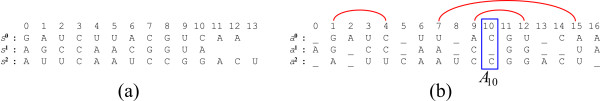
An SAF instance, and a corresponding alignment with folding. (a) An SAF instance S, composed of three RNA strings s0, s1, and s2. (b) A possible alignment with folding (A, F) of S, where |A| = 17, and F = {1 • 4, 7 • 15, 9 • 12}. The alignment column A10 is marked. This column corresponds to the sub-instance SQ, Q', for Q = (7, 7, 8) and Q' = (8, 7, 9).